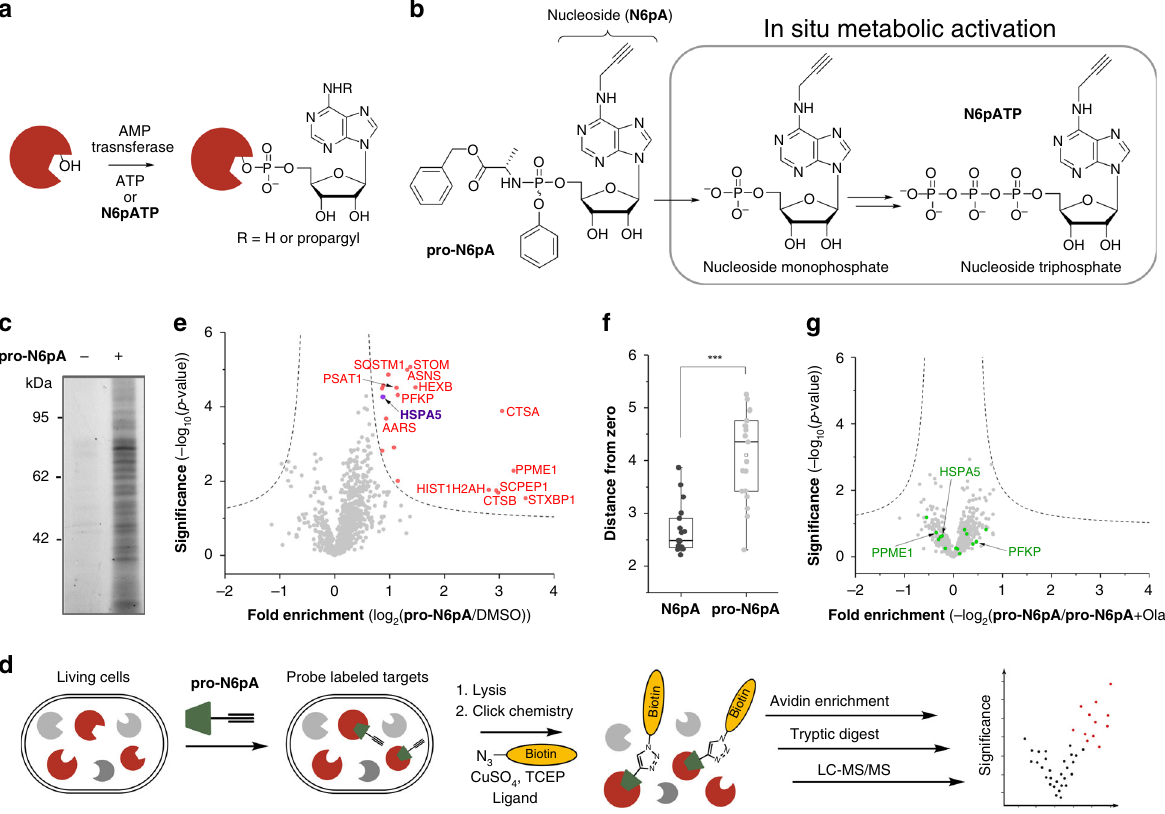
Fig. 1 Pronucleotide probe reveals AMPylation of diverse proteins in HeLa cells. a AMPylation on Ser, Thr or Tyr. b Scheme of the pronucleotide probe pro-N6pA and parent adenosine derivative ( N6pA ) and its in situ activation. c SDS – PAGE with in-gel fl uorescence scanning showing in situ HeLa cell labelling by pro-N6pA compared to control (DMSO). d Schematic representation of the chemical-proteomic approach used for in situ identi fi cation of AMPylated proteins. e Volcano plot of fold-enrichment in HeLa cells by pro-N6pA labelling compared to DMSO versus signi fi cance upon two-sample t -test (FDR 0.05, s0 0.3; n = 12). f Box plot representing comparison of labelling ef fi ciency of pronucleotide pro-N6pA (light grey, n = 12) and parent nucleoside N6pA (black, n = 11); Squares represent the mean of the distances to zero for enriched proteins, lines represent the median of the distances to zero and whiskers stand for min and max values. Statistical signi fi cance was calculated with two-tailed Student ’ s t -test; *** P < 0.001. g Volcano plot of fold- enrichment by pro-N6pA labelling compared to probe and Ola treated HeLa cells versus signi fi cance upon two-sample t -test (FDR 0.05, s0 0.3; n = 8). Green circles represent proteins identi fi ed as AMPylated in HeLa